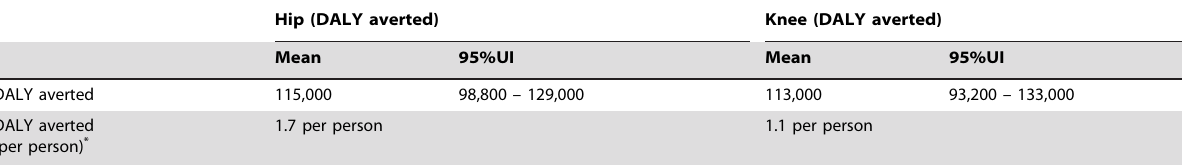
Table 6. Health gains.